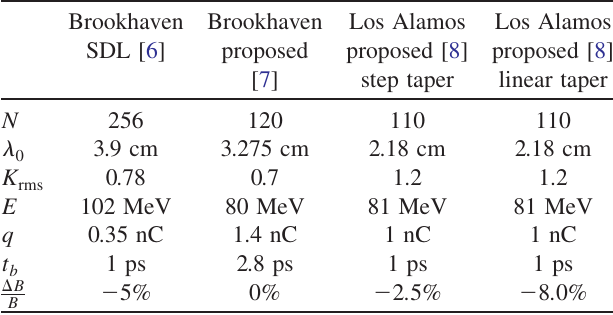
TABLE I. FEL amplifier parameters, where N is the number of undulator periods, (cid:4) 0 is the length of a single undulator period, E is the beam energy, q is the K rms is the undulator parameter, bunch charge, t b is the bunch duration, and (cid:4) B=B is the undulator taper rate.